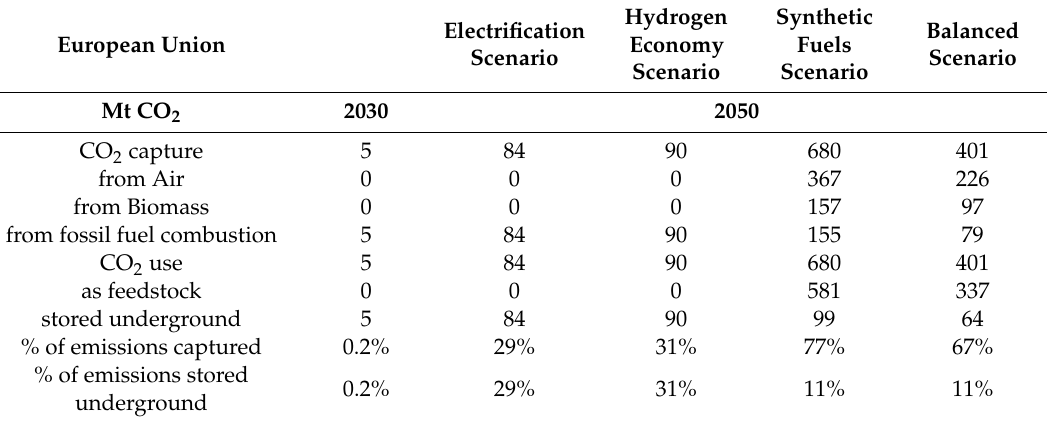
Table 4. CO 2 Capture, Use and